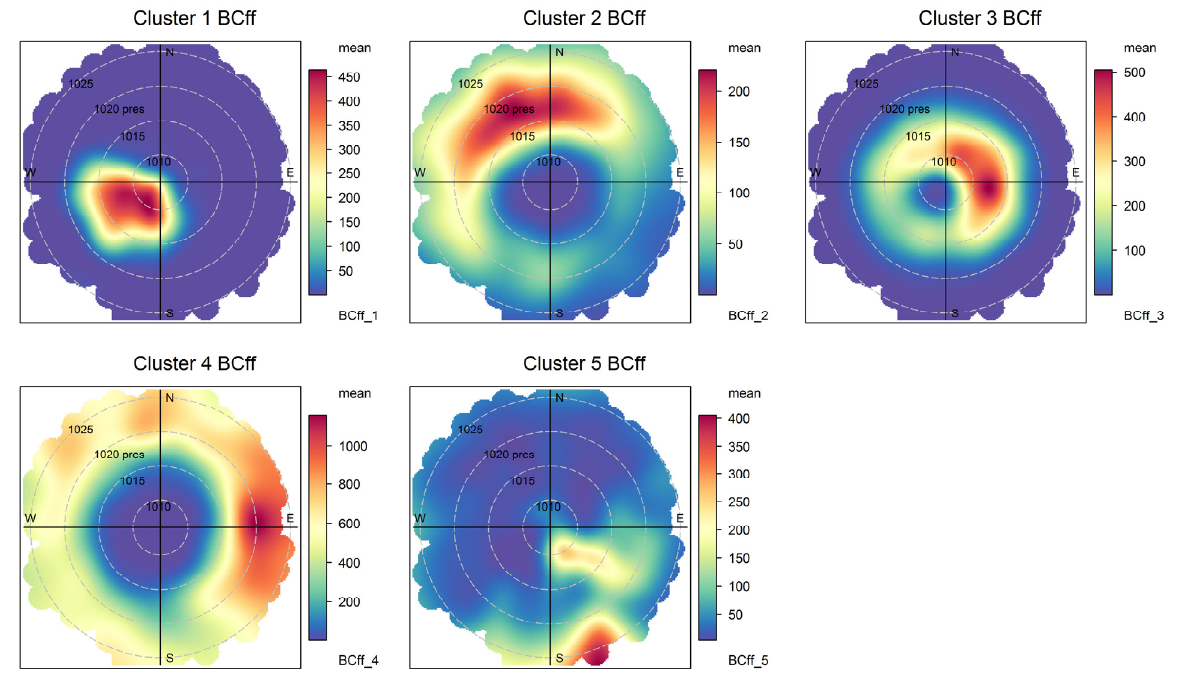
Figure A4. Bivariate plot of hourly BC ff contributions, 2020 campaign, using temperature instead of wind speed.